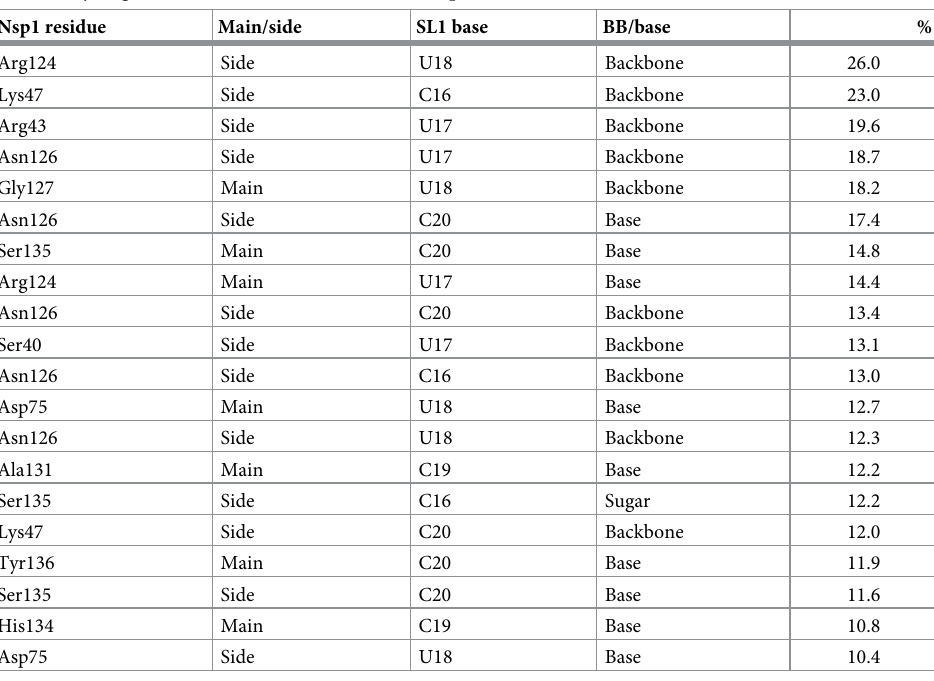
Table 1. Hydrogen bonds observed between SL1 and